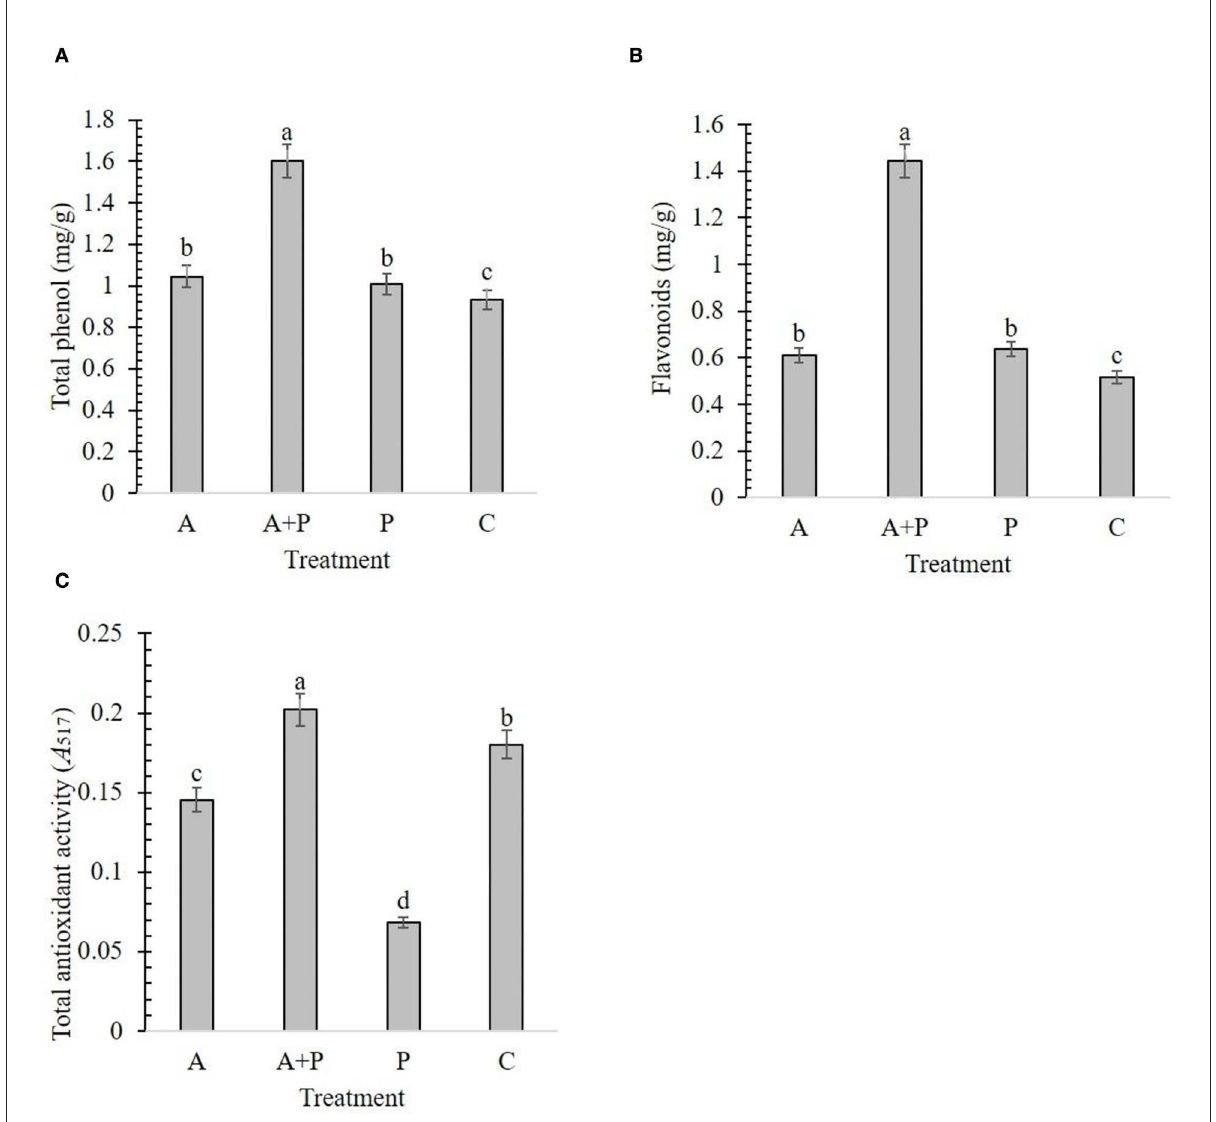
FIGURE2 Effect of different treatments [A, alga ( S. angustifolium ) extract; A + P, pathogen ( M. phaseolina )-inoculated pre-treated with the alga extract; P, pathogen-inoculated; C, control] and on some biochemical factors of the strawberry plant including total phenol (A) , flavonoids (B) , and total antioxidant activity (C) . Letters on bars show the significant difference between the treatments according to the results of Duncan’s multiple range test.